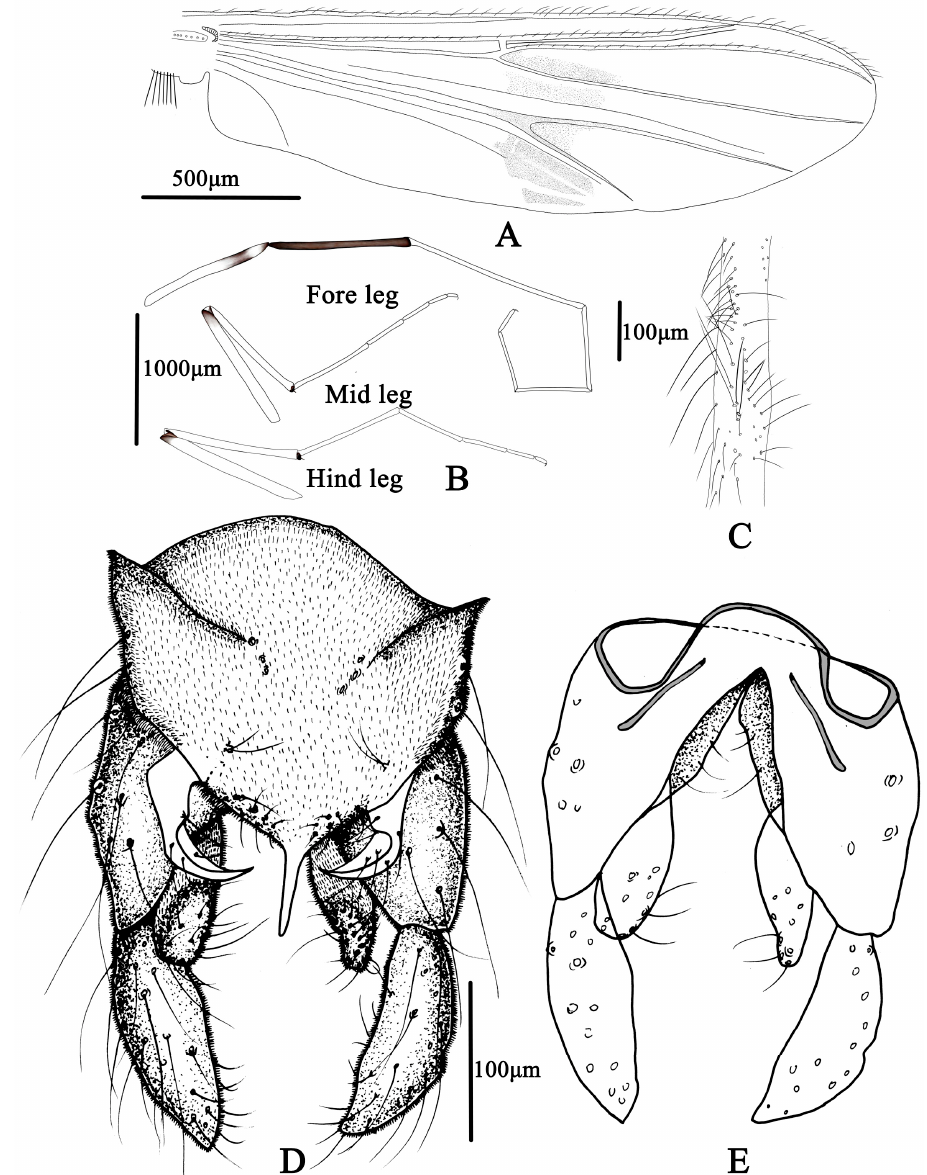
Figure 13. Male adult of Microtendipes wuyiensis sp. nov.: ( A ) wing; ( B ) legs; ( C ) directed setae in front femur; ( D ) hypopygium in dorsal view; ( E ) hypopygium in ventral view. Type material. Holotype: male (Sample ID: ZJCH382, Field ID: WYS185), China, Fujian Province, Nanping City, Wuyi Mountain National Reserve, N 27.6016, E 117.7891, 17 April 2021, leg. K.H. ZHONG, light trap. Paratypes: three males, the same data as for hol- otype.